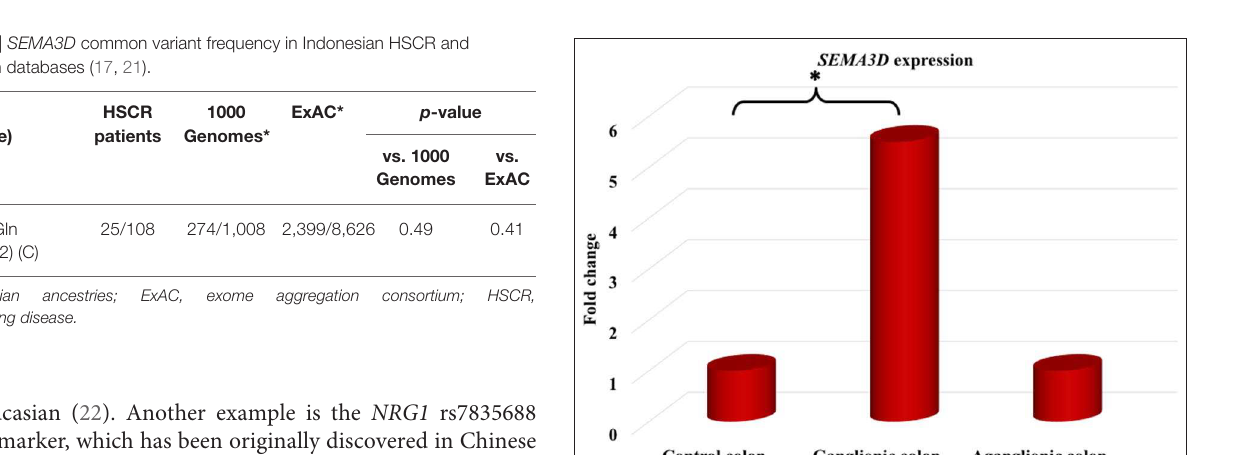
FIGURE 1 | Sanger sequencing of exon 17 SEMA3D gene in a HSCR patient. Arrow indicates a common variant, p.Lys701Gln (rs7800072).